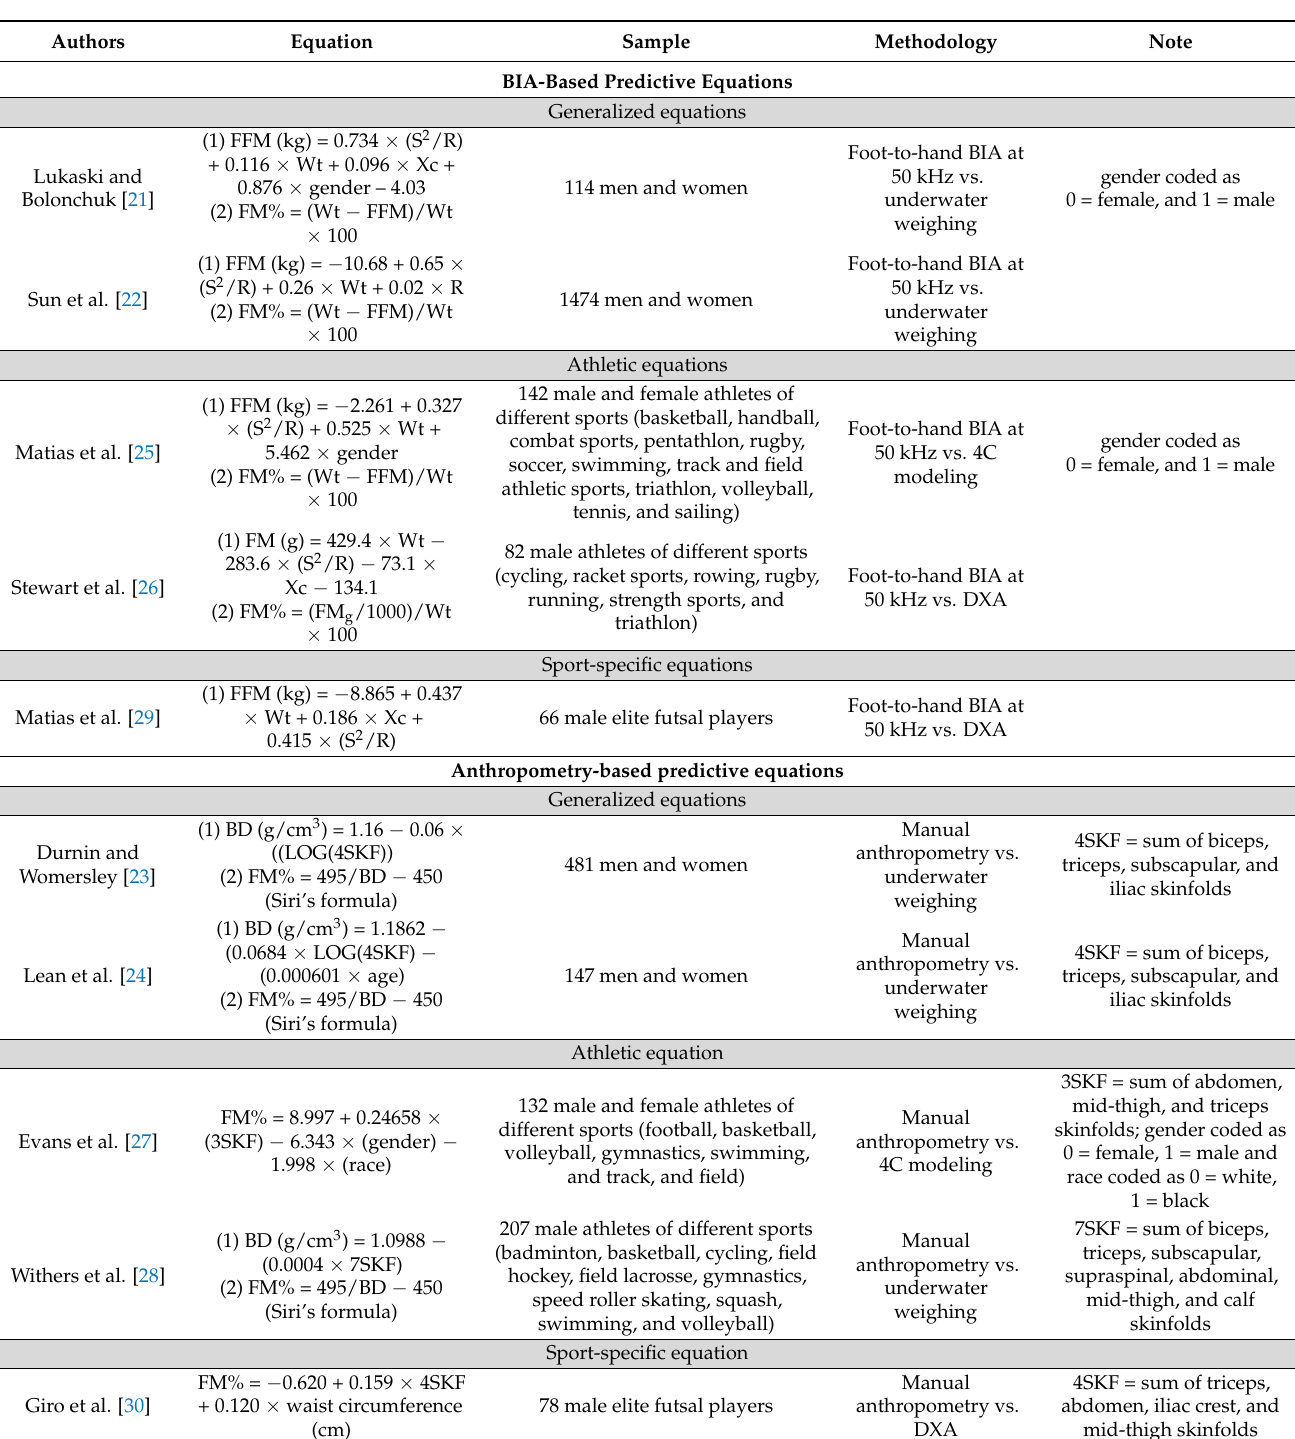
Table 1. Characteristics of the selected BIA- and anthropometry-based predictive equations for fat mass